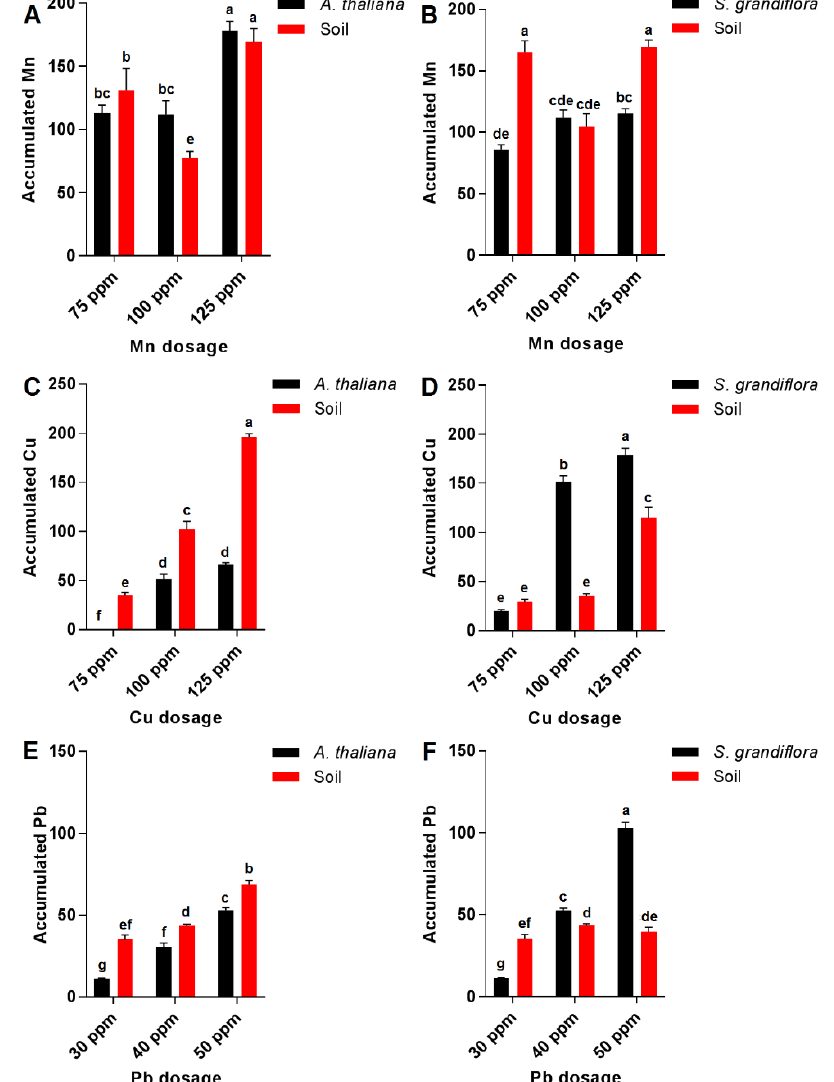
Figure 2. Accumulated Mn (A and B); Cu (C and D); and Pb (E and F) in CYP4502E1 expressing A. thaliana and S. grandiflora plants and in the soil where they were grown under different heavy metal